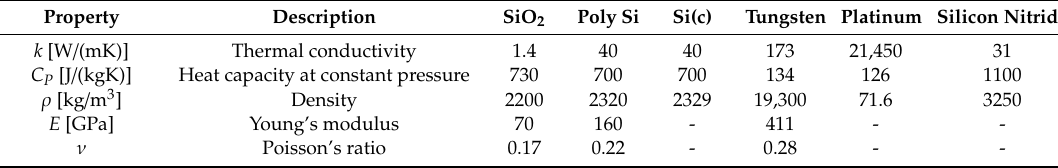
Figure 3. The 3D ANSYS model. Table 1. Materials thermal and mechanical properties used in this article simulations. The thin film silicon device layer is assumed to have the thermal conductivity of polysilicon rather than bulk crystalline silicon.